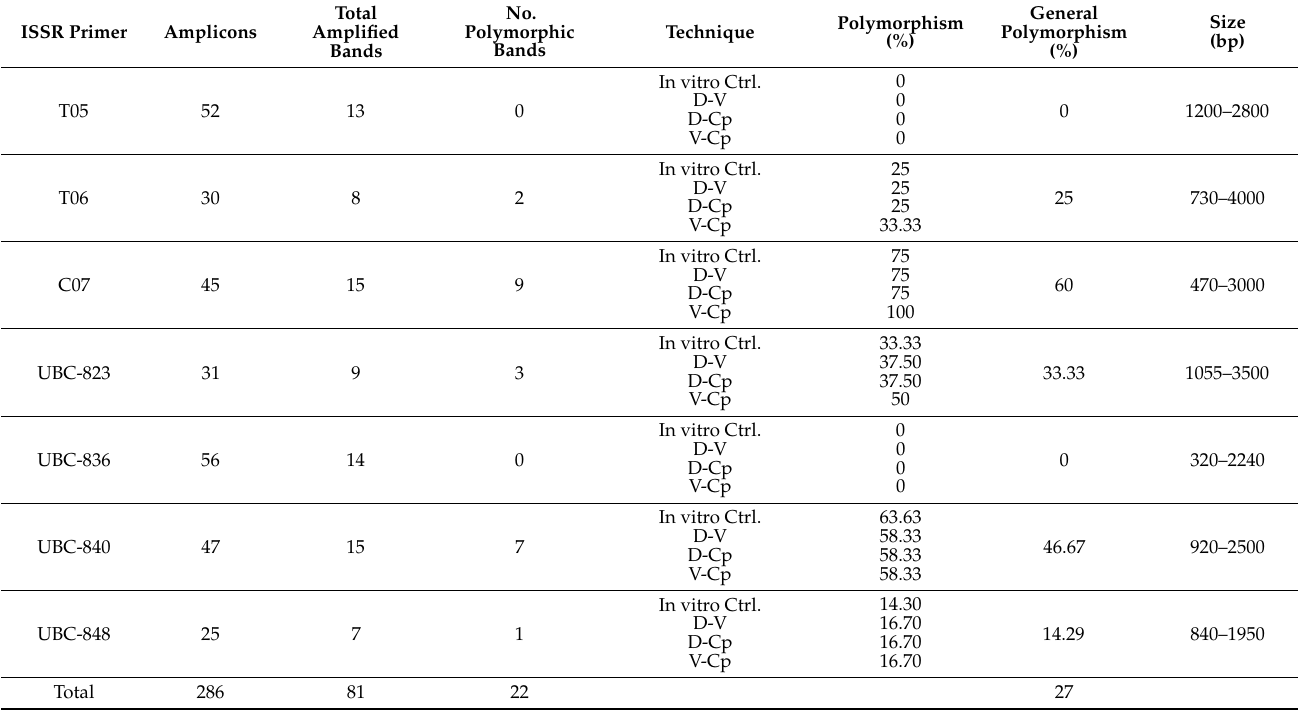
Table 4. Analysis of electrophoretic profiles with the ISSR primers (T05, T06, C07, UBC-823, UBC-836, UBC-840 and UBC-848) to detect polymorphisms in greenhouse-grown V. planifolia in vitro controls and in cryo-derived regenerants using three vitrification-based